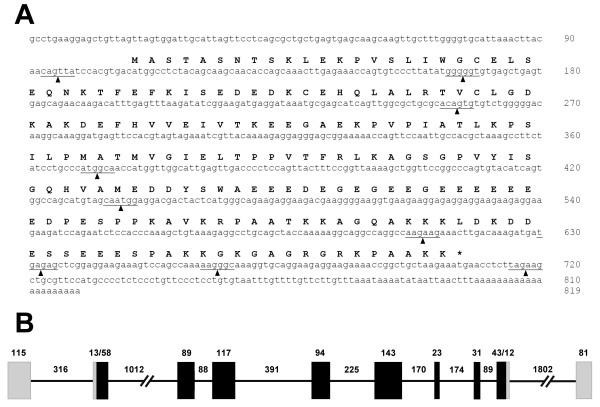
X. tropicalis nucleoplasmin gene. A) Nucleotide sequence and corresponding protein sequence of a nucleoplasmin cDNA from X. tropicalis [GenBank: NM_001016938]. The arrow heads and lines indicate the sites of insertion of the different introns. B) Schematic representation of the organization and structure of the gene. Exons are schematically represented by solid boxes, with black representing translated regions and grey representing untranslated regions. Introns are indicated by black lines. The numbers indicate the basepair size of the regions below them.